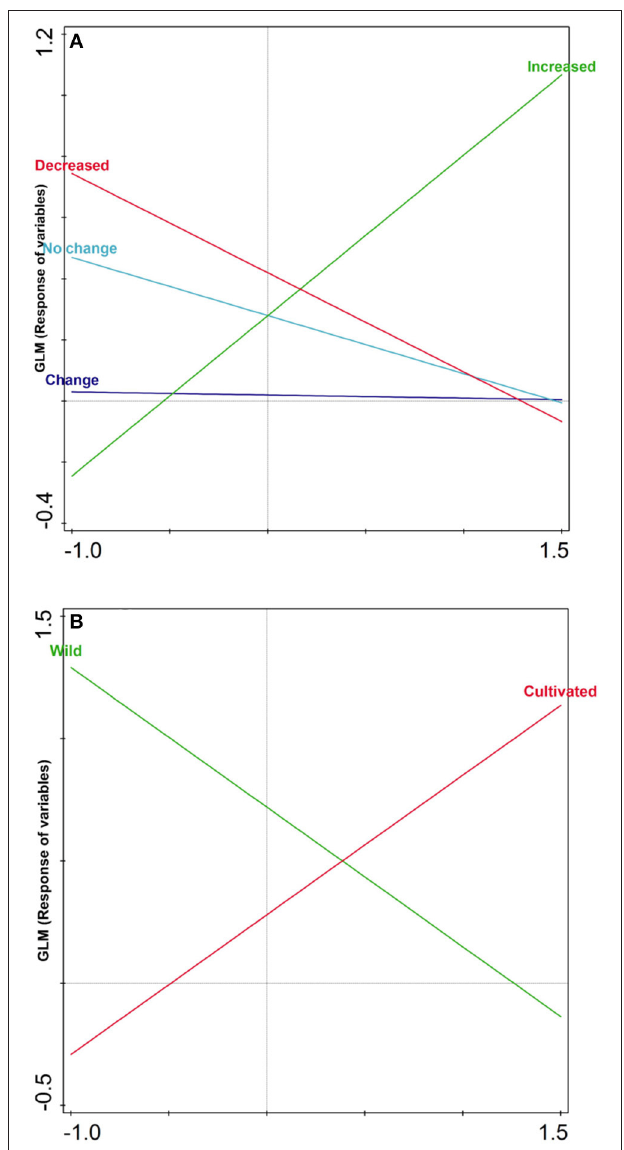
FIGURE 2 | Species response curve shows the significance level among various variables conservation status (A) and nature of plant (B) on the basis of their frequency.